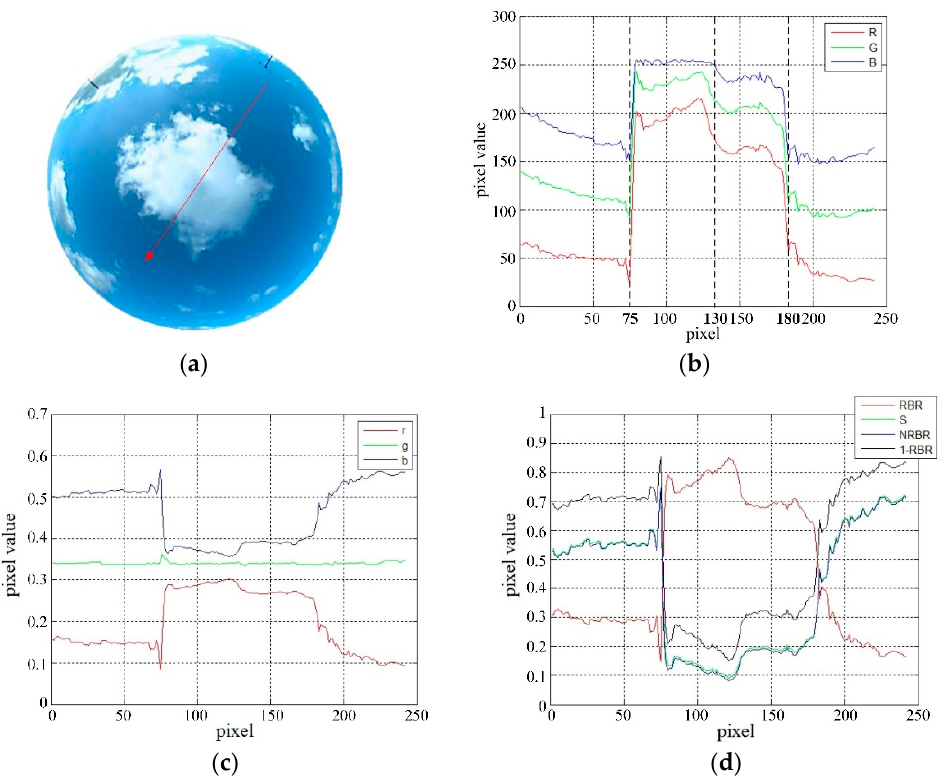
Figure 9. Discussion of the color channels and several features: ( a ) Original image with the red strip, ( b ) linear histogram of RGB channels, ( c ) linear histogram of the chromaticity coordinates, ( d ) relationship of the three features.